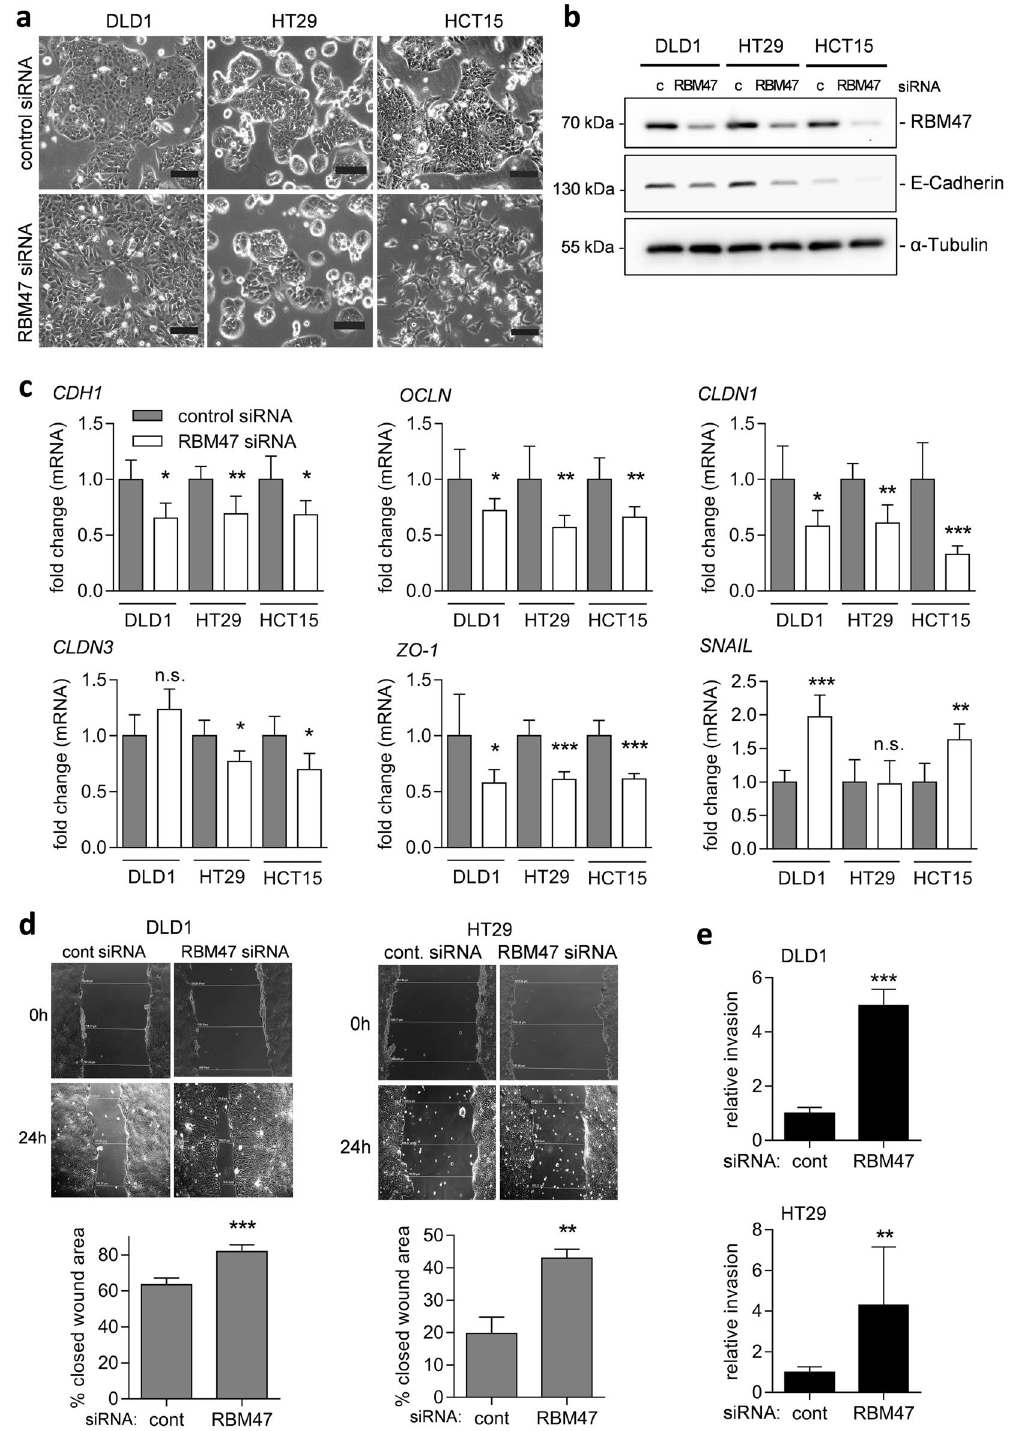
Figure 7. Inhibition of RBM47 induces EMT, cell migration and invasion. ( a ) Phase contrast microscopy of the indicated CRC cell lines transfected with control or RBM47 -specific siRNA. Scale bars represent 100 μ m. ( b ) Western blot analysis of the indicated proteins in CRC cell lines transfected with control or RBM47 -specific siRNA for 72 h. ( c ) qPCR analysis of the indicated mRNAs in the indicated CRC cell lines transfected with control or RBM47 -specific siRNA for 72 h. ( d ) Wound healing assay of the indicated CRC cell lines transfected with control or RBM47 -specific siRNA 48 hours before a scratch was generated. (Upper panels) Representative photographs of the initial wound area and the same area 24 hours later. (Lower panels) Quantification of wound closures: The width of scratches in 2 independent wells was analyzed for each state. Results represent the average (%) of wound closure. ( e ) Relative invasion of indicated CRC cells in matrigel-coated Boyden chambers transfected with control or RBM47-specific siRNA for 48 hours. In c, d, and e mean values ± SD (n = 3) are provided. * P < 0.05; ** P < 0.01; *** P <